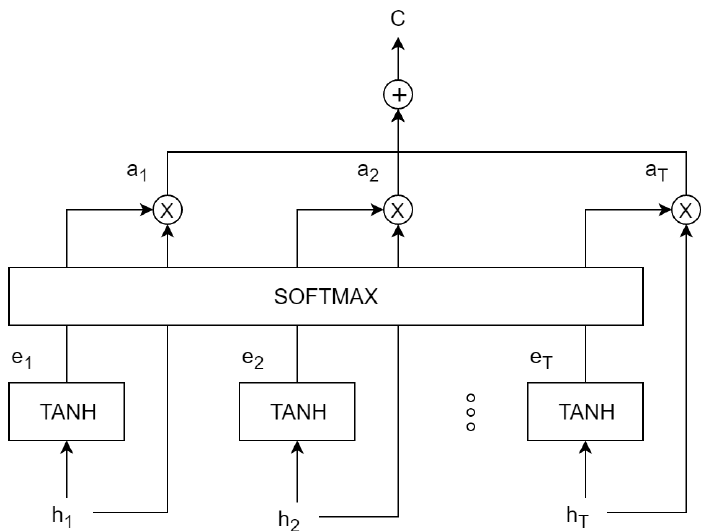
Figure 2. Graphical illustration of the implemented attention